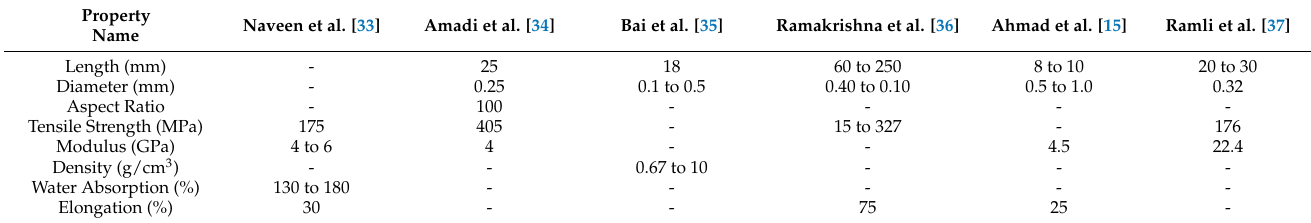
Table 1. Physical properties of coconut